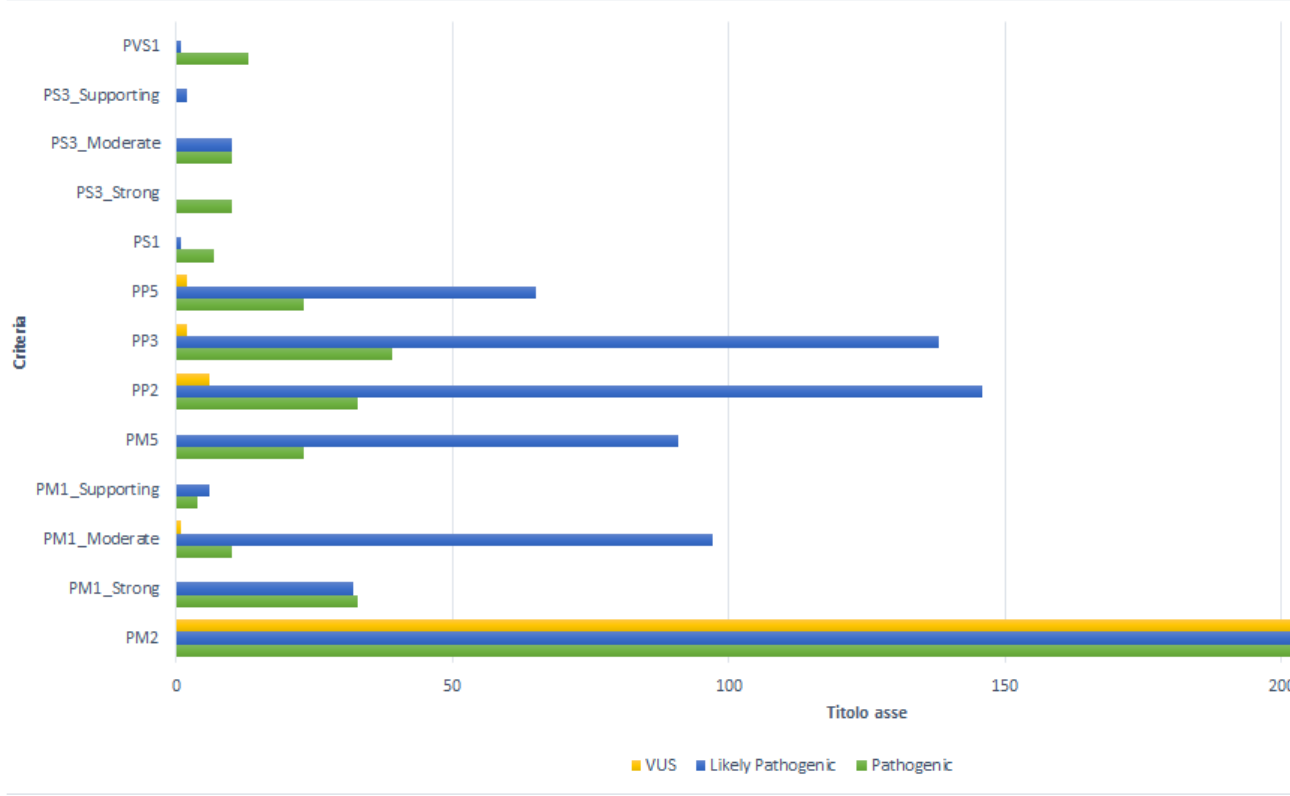
Figure 3. Contribution of each criterion to the final classification.